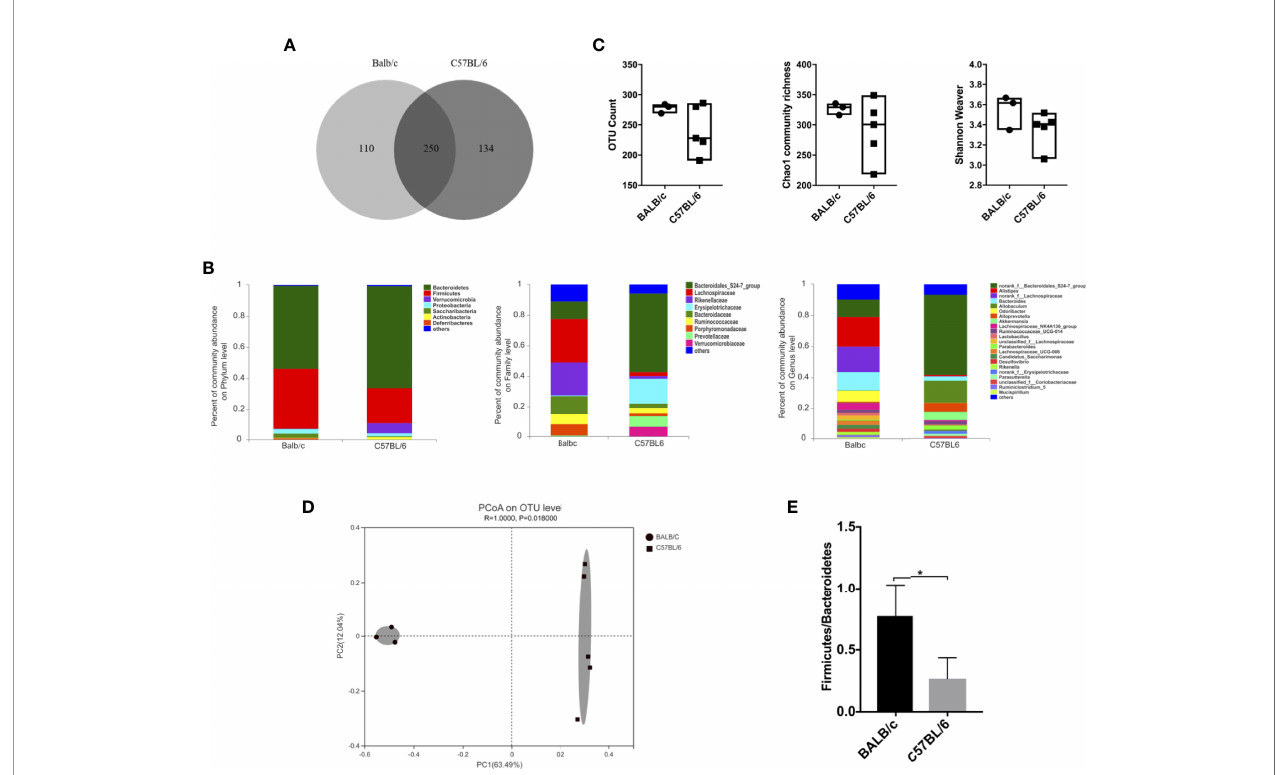
FIGURE 2 | Comparison of the gut microbiota between naïve BALB/c and C57BL/6 mice. 16S rRNA in fecal pellets from naïve BALB/c and C57BL/6 mice was sequenced. (A) Venn diagram showing shared and unique OTUs. (B) Gut microbiota composition at the phylum, family, and genus levels. (C) a -Diversity based on OTU counts, Chao1 community richness, and the Shannon – Weaver index. (D) b -Diversity based on Bray-Curtis dissimilarity. (E) Firmicutes/Bacteroidetes ratio calculated on the basis of the abundance of each bacterial species. n = 3 in BALB/c group, n = 5 in C57BL/6 group, * P <